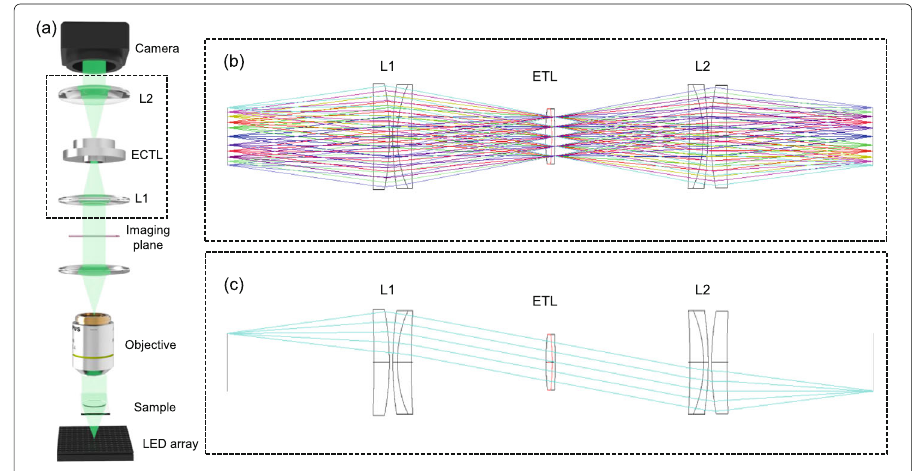
Fig. 35 Optical design of the MQP-SCLM. (a) Optical path of the MQP-SCLM. (b) General light tracing diagram of the system. (c) Light tracing diagram of the